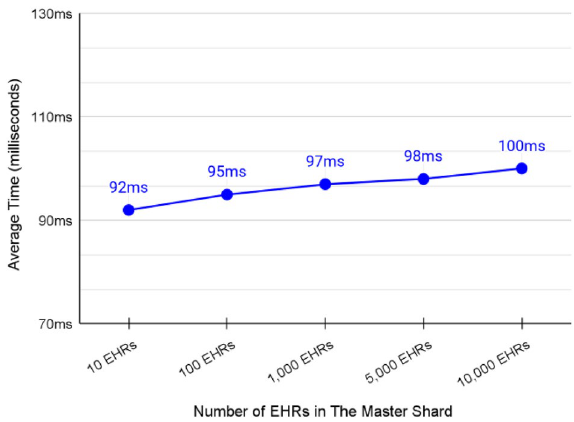
Figure 18. Average transaction speed of querying the latest EHRs page from the master